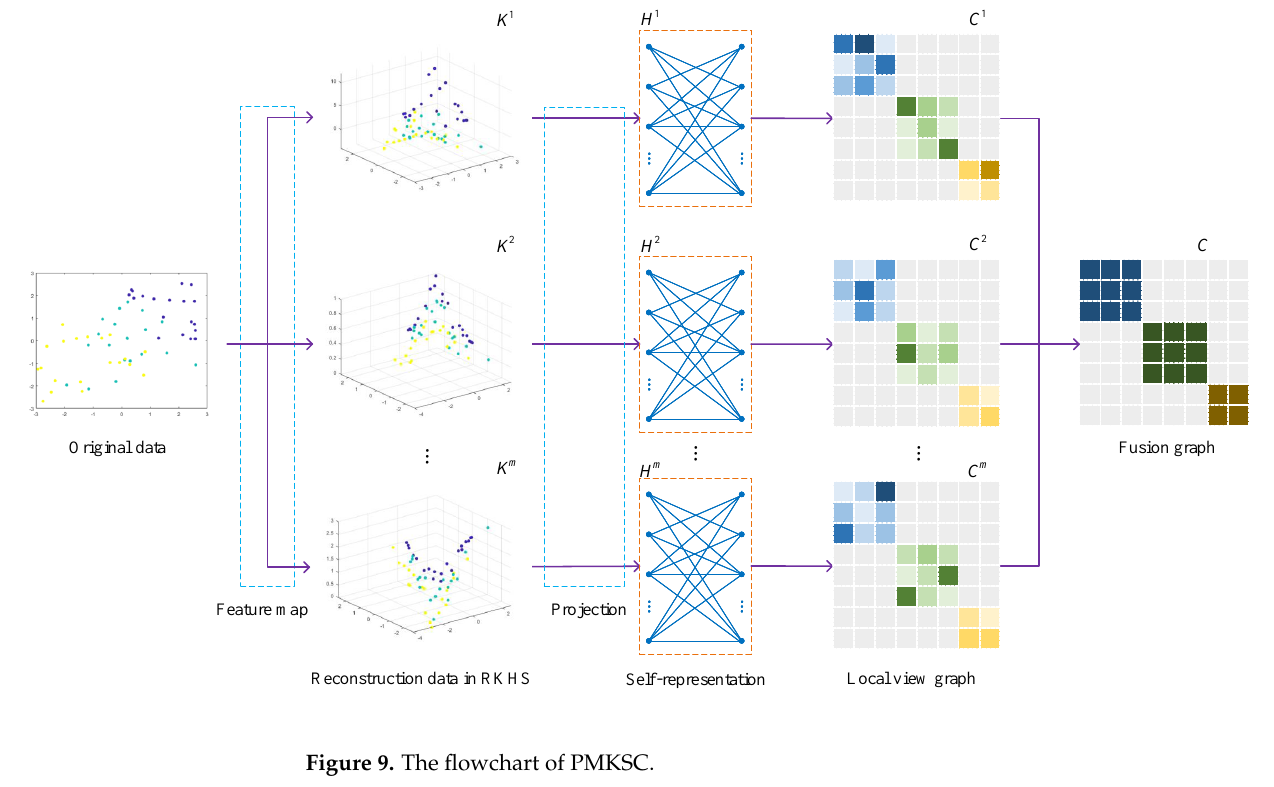
Figure 9. The flowchart of